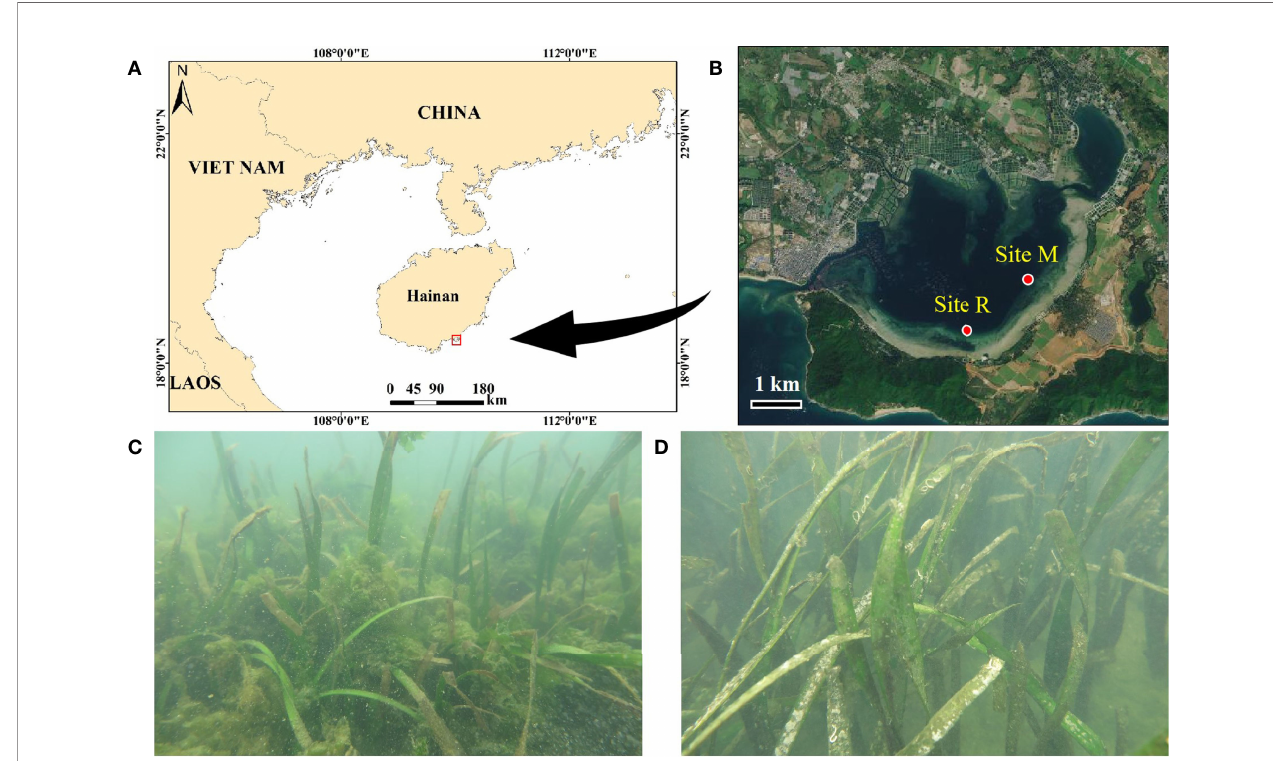
FIGURE 1 | Locations of Xincun Bay Lagoon (A) and the two seagrass sites (B) , and respective typical scenes from the two seagrass sites, site M (C) and site R (D) . Site M represents the nutrient enrichment site with macroalgal blooms, and site R represents the reference site without apparent macroalgal blooms. The panels A and B were created with image obtained from ArcGIS version 10.3 and National Platform for Common Geospatial Information Services (https:// map.tianditu.gov.cn),